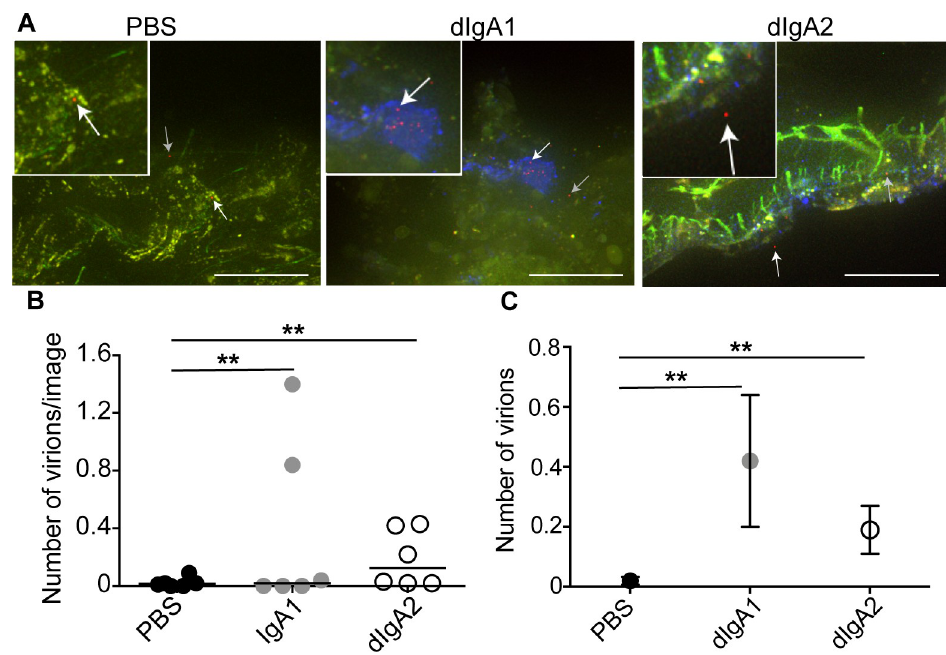
Fig 5. Number of virions in mesenteric lymph nodes 2 hours after rectal challenge is IgA dependent. Eighteen animals were challenged rectally with PBS, dIgA1-Cy5 or dIgA2-Cy5 and a mixture of PA-GFP-BaL and PA-GFP-BaL 64 Cu ( Table 1, protocol 3). Two hours later, animals were sacrificed, mesenteric lymph nodes removed, individually frozen and OCT blocks with moderate to high PET signal cryosectioned. ( A ) Representative fluorescent microscopy images of nodes from each of the three experimental groups (PBS negative control, dIgA1-Cy5 and dIgA2-Cy5). Red, GFP/HIV virion (post-activation); blue, dIgA; green, autofluorescence (pre-activation). White arrows indicate HIV virions in insets; grey arrows show other viral particles in micrograph. Scale bars, 20 μ m. ( B-C ) Quantification of total number of virions found in cryosections of mesenteric lymph nodes for the experiment in Fig 3 ( Table 1 , protocol 3). ( B ) Dots depict individual animals and bars depict. ( C ) Circles and bars, estimated means and standard errors; n = 6 animals/group (18 animals total); �� , P < 0.01.